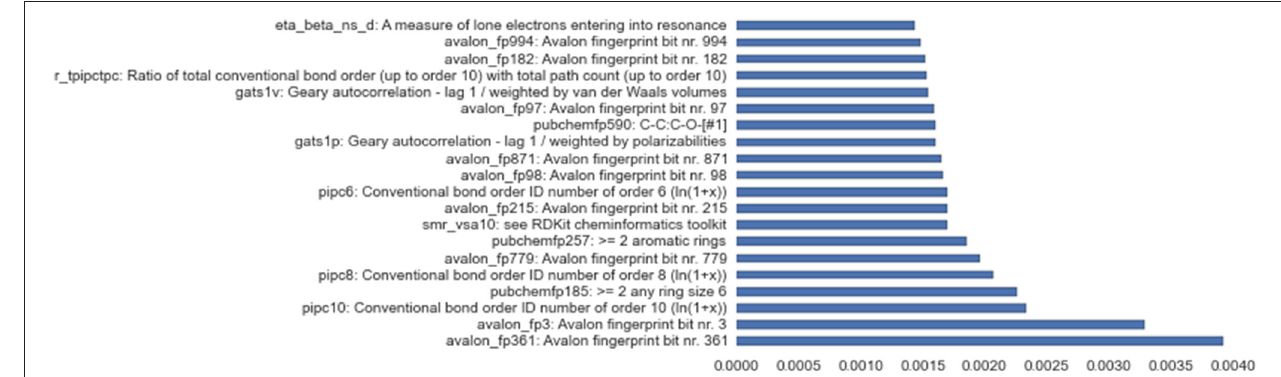
FIGURE 6 | Top 20 empirical feature importance assessment on assay SR-P53.